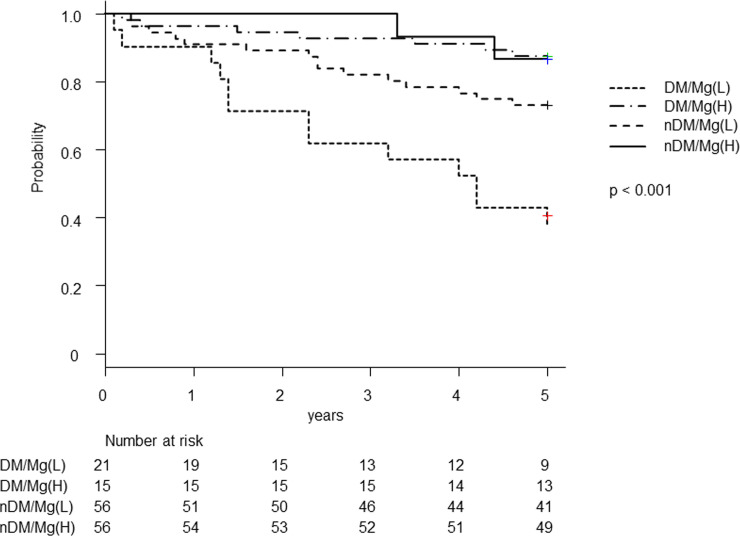
Kaplan–Meier product–limit function estimates for time-to-event analysis by the four groups.The endpoint was all-cause death or hospitalization for decline of ADL. The 5-y survival rate in the DM/Mg(L) group was noted to be significantly low (P < 0.001).